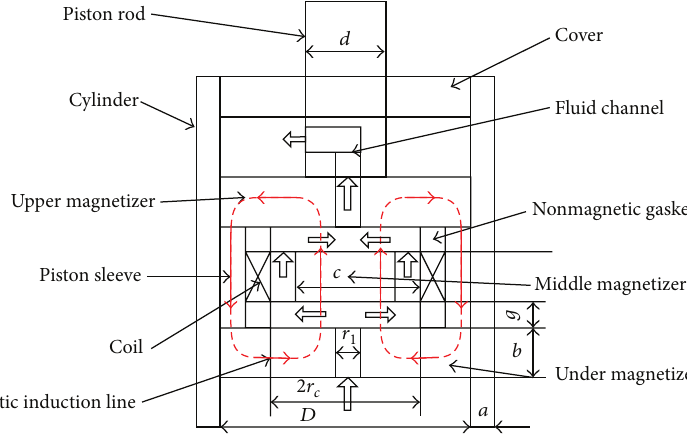
Figure 1: The structure principle of damper with the type of inner channel.